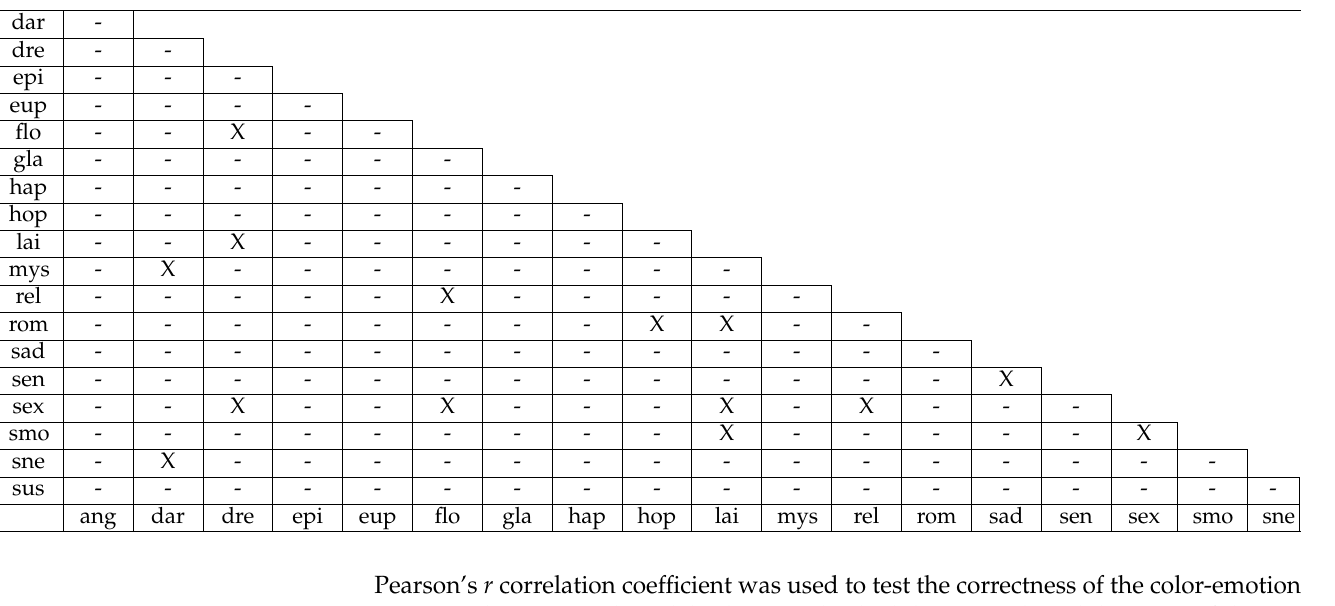
Table 6. Results of the chi-square test for 19 emotions from the Epidemic Sound database (labels are the same as shown in Table 5).